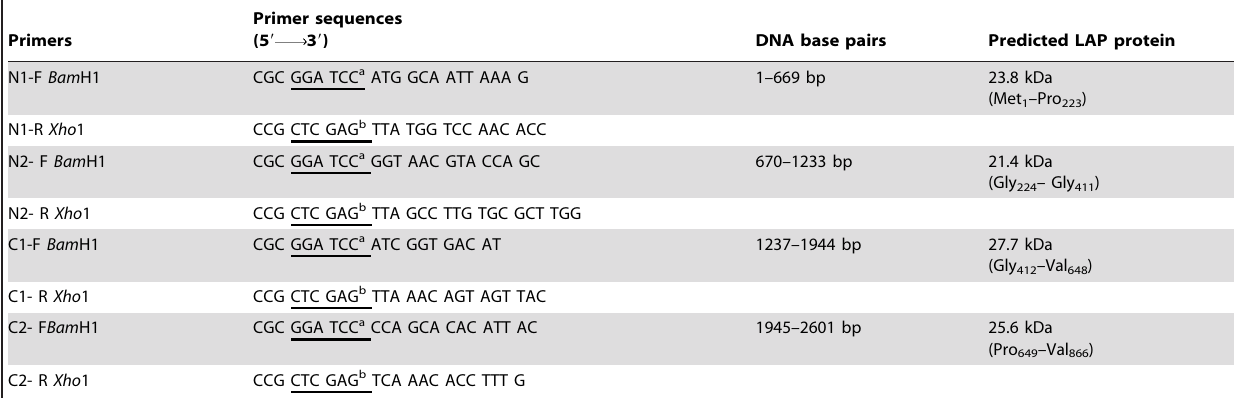
Table 1. Primer sequences and LAP subdomain